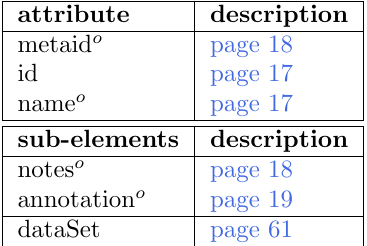
Table 2.27: Attributes and nested elements for report. xy o denotes optional elements and attributes.